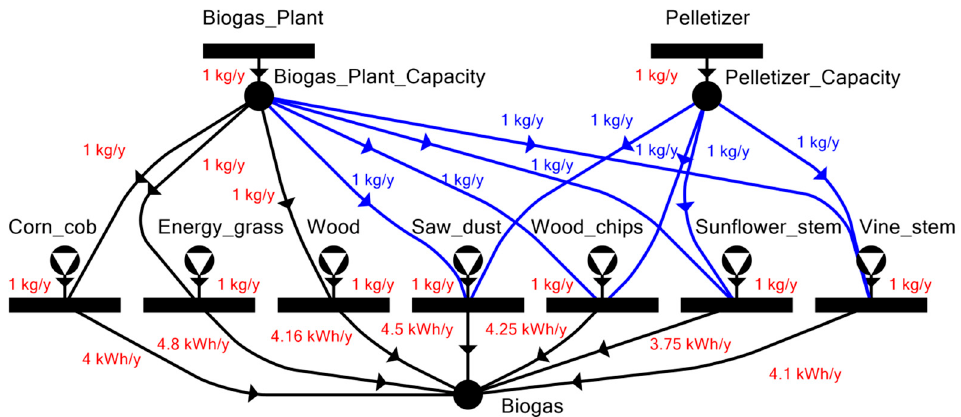
Figure 9. Final model for the potential biomass supply in the manufacturing plant. Note that the simplification resulted in seven logical operating units performing heating value conversions for each available biomass